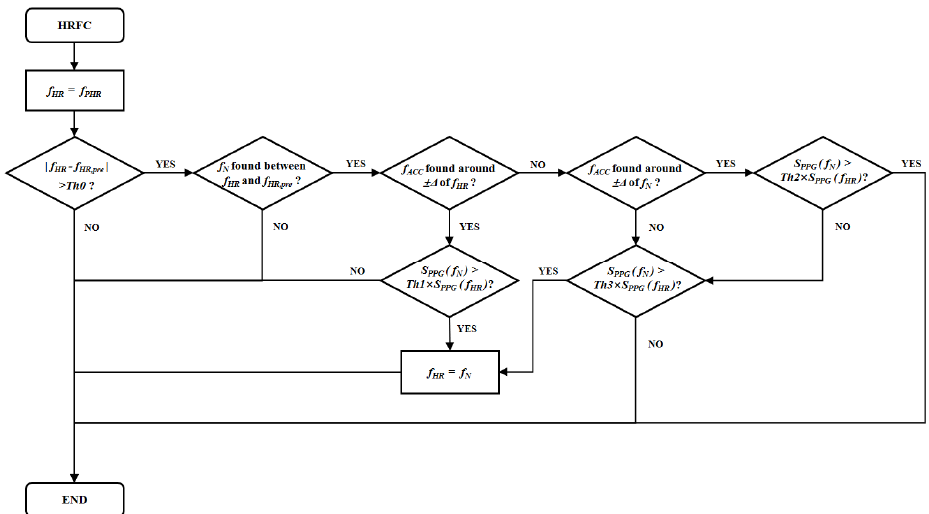
Figure 4. Flowchart of the heart rate frequency correction.